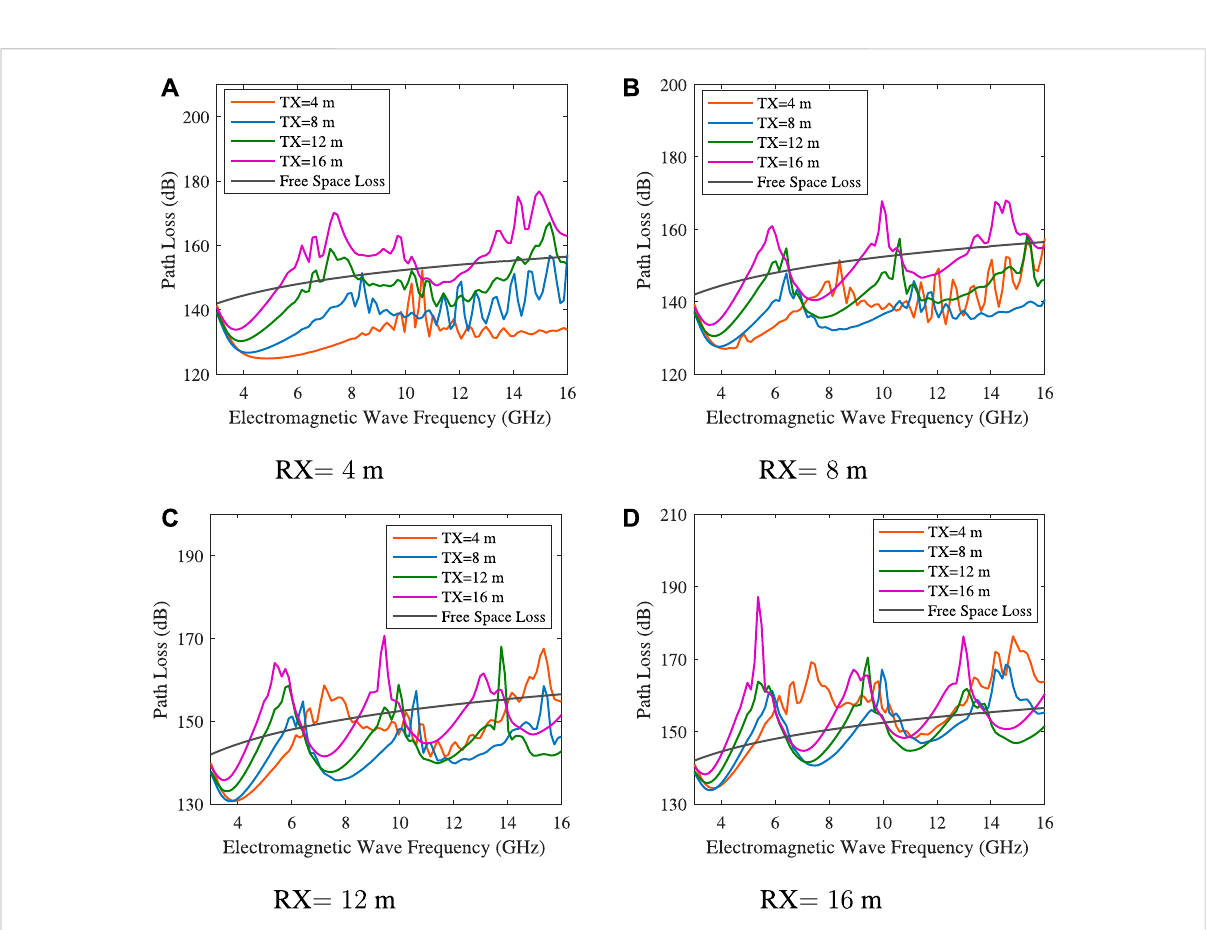
FIGURE 7 In fl uence of frequency on path loss at different antenna height. (A) RX = 4 m. (B) RX = 8 m. (C) RX = 12 m. (D) RX = 16 m.